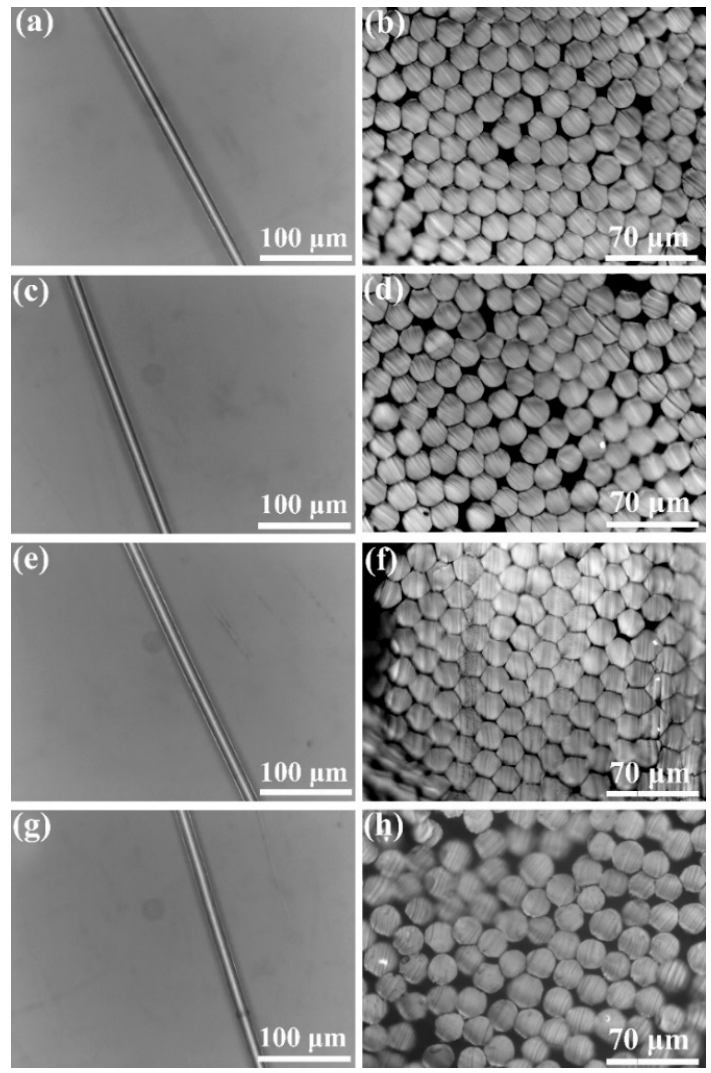
Figure 5. Optical microscopic images of filament (left) and transverse surfaces (right) of ( a , b ) pure POM fiber and POM/PLLA bicomponent fibers containing ( c , d ) 5, ( e , f ) 10, and ( g , h ) 20 wt % PLLA at the ultimate draw ratio.